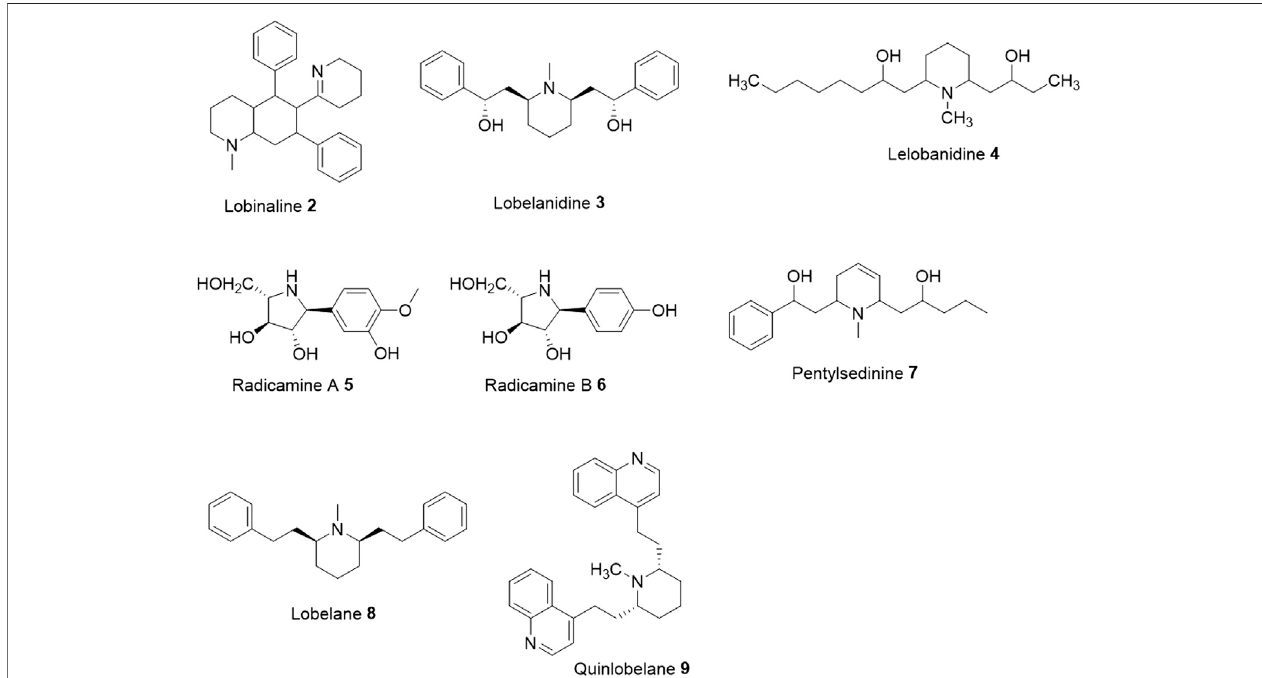
FIGURE 2 | Chemical structures of the bioactive alkaloids derived from Lobelia